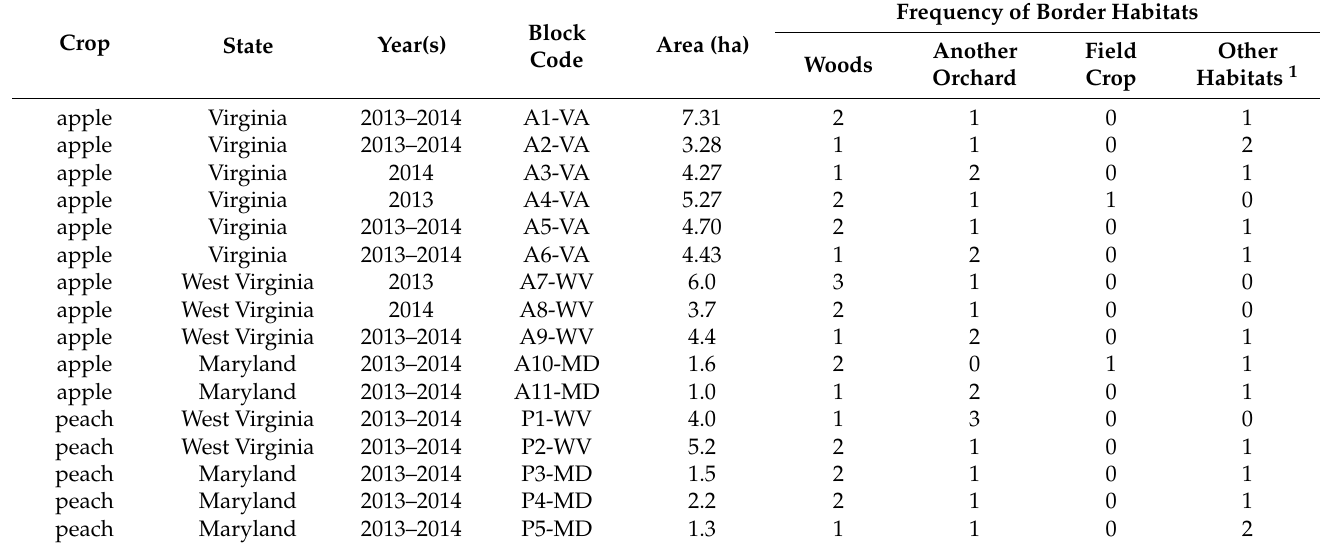
Table 1. Physical characteristics of commercial apple and peach orchard blocks in Virginia, West Virginia, and Maryland used to assess the effects of border habitat on H. halys captures and fruit injury at